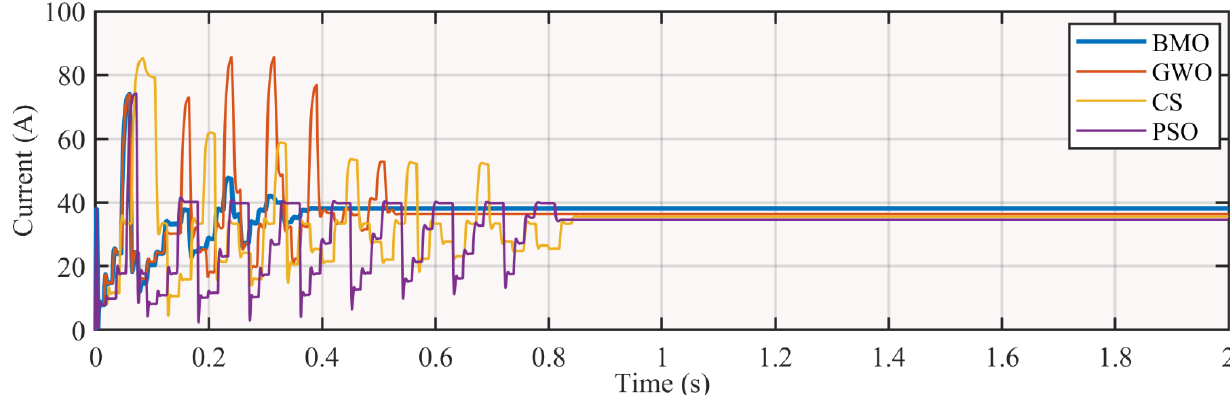
Figure 12. Competing techniques current Case-1.